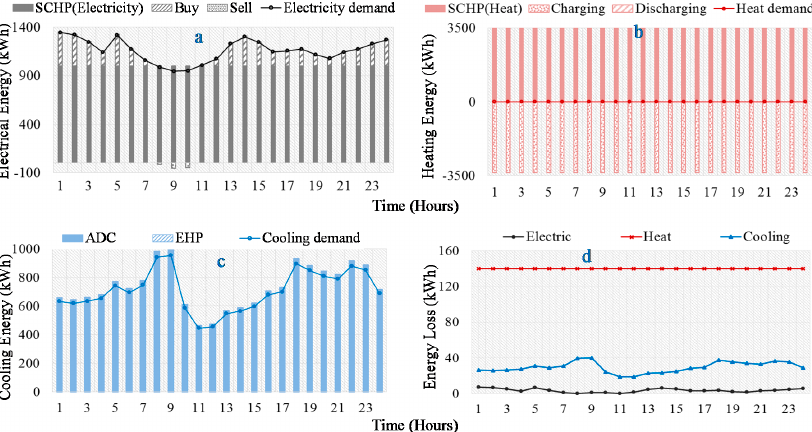
Figure 6. Energy balancing of BMG1 in summer season: ( a ) electrical energy; ( b ) heating energy; ( c ) cooling energy; and ( d ) energy loss.